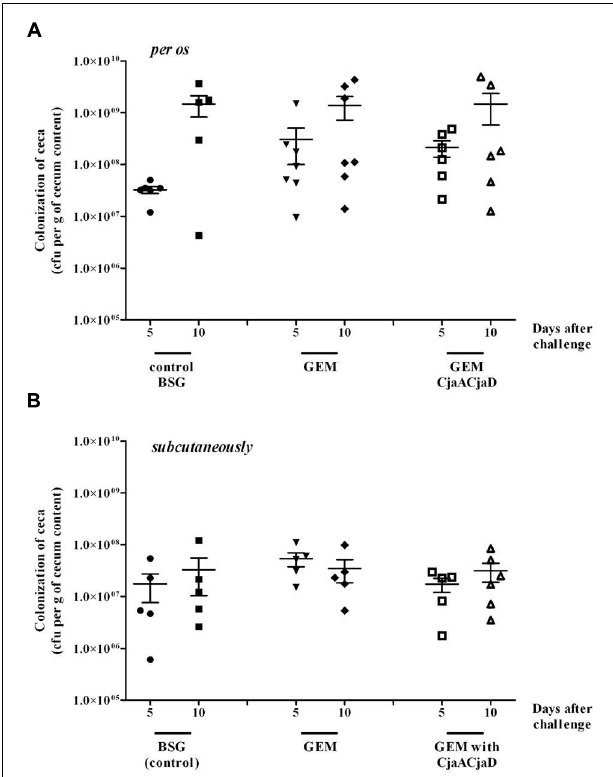
FIGURE 1 | Colonization of chickens vaccinated with GEM particles or GEM particles presenting CjaA-LysM and CjaD-LysM on their surface and then given a Campylobacter jejuni challenge. Chickens were orally (A) or subcutaneously (B) given three doses of the vaccine at 1, 9, and 19 days after hatch and challenged with C. jejuni 12/pUOA18 at the 30th day of life. Control birds were given BSG (PBS with 0,01% gelatin). Viable C. jejuni cells were recovered from the ceca of chickens at specified days after challenge. Bacterial recoveries represent colonization levels of 6 or 7 birds per time interval. The geometric mean for each group is denoted by bars. No significant differences ( p < 0.05) between groups were